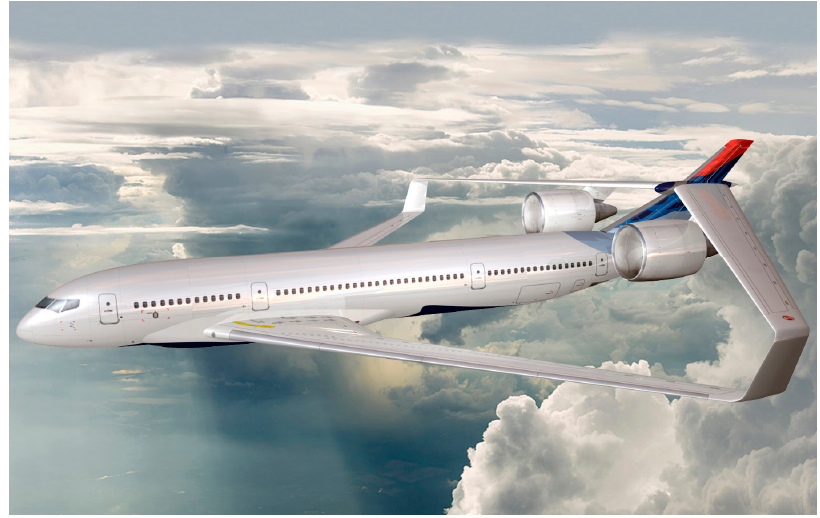
Figure 1. Box-Wing Aircraft (BWA) design from Lockheed Martin (with NASA courtesy).